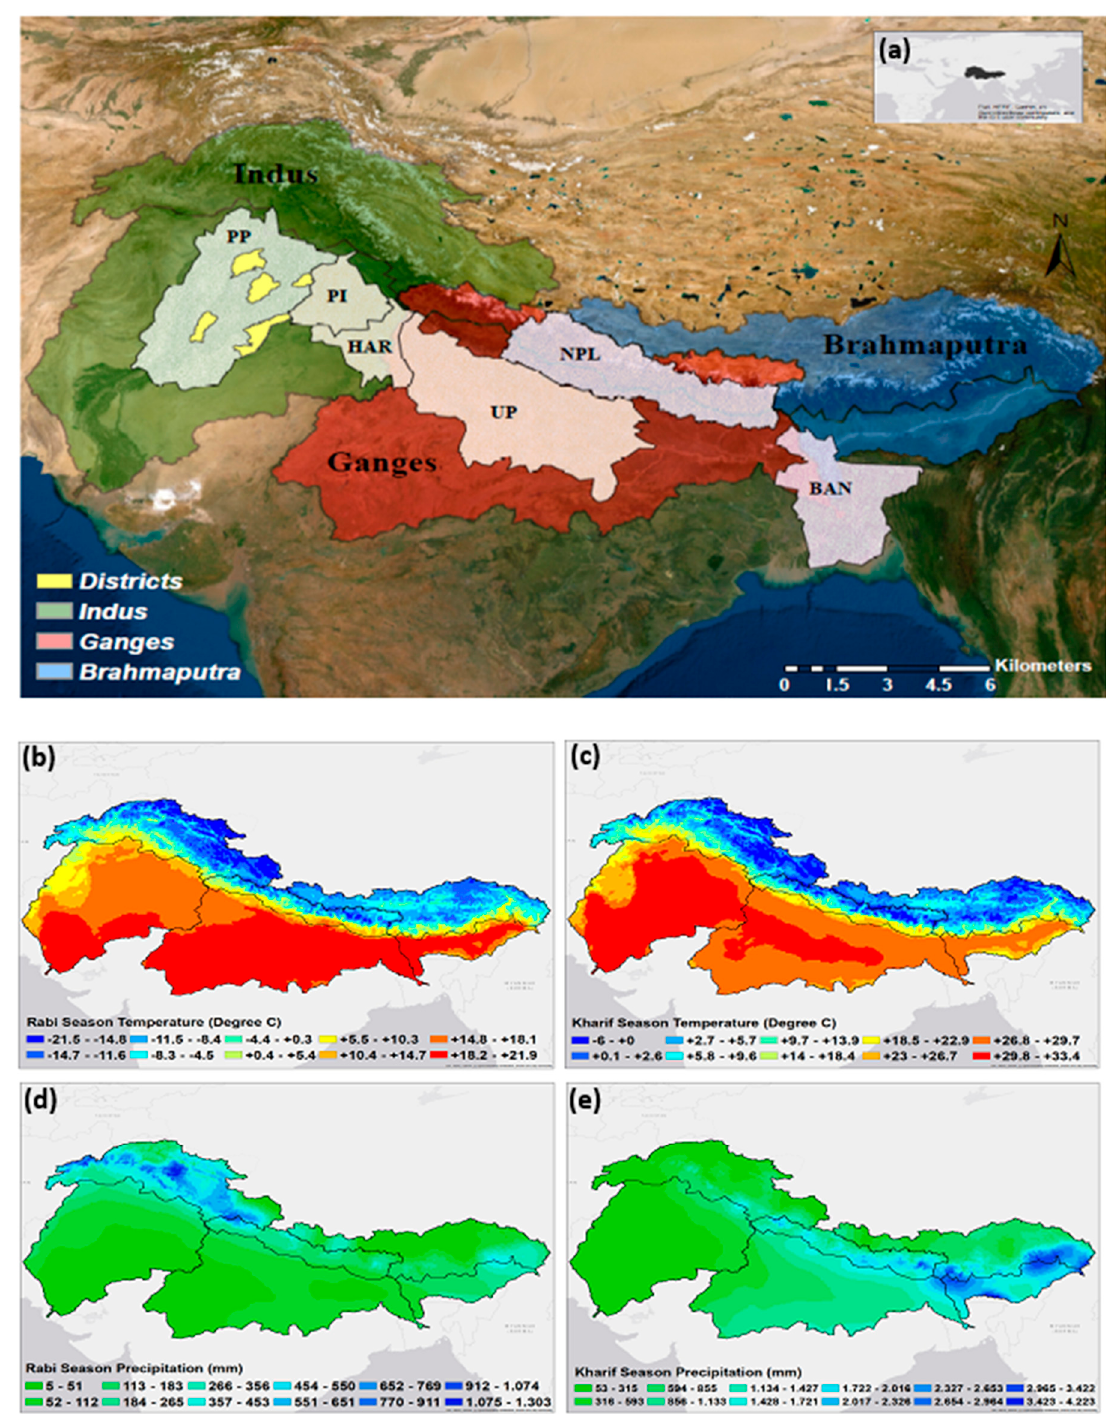
Figure 1. Area map showing upper and lower parts of the Indus, Ganges and Brahmaputra (IGB) river basins with selected study sites including districts in Punjab province Pakistan, Punjab Pakistan (PP), Punjab India (PI), Haryana (HAR), Uttar Pradesh (UP), Terai region Nepal (NPL) and Bangladeshi districts (BAN) ( a ), 30 years mean rabi season temperature ( ◦ C) ( b ), 30 years mean kharif season temperature ( ◦ C) ( c ), 30 years mean rabi season precipitation (mm) ( d ) and 30 years mean kharif season precipitation (mm) ( e ) maps during 1981–2010 over whole IGB river basins. Climate data (i.e., temperature and precipitations) at 5 arc-min spatial resolutions has been acquired from HI-AWARE data archive, particularly developed for the IGB river basins